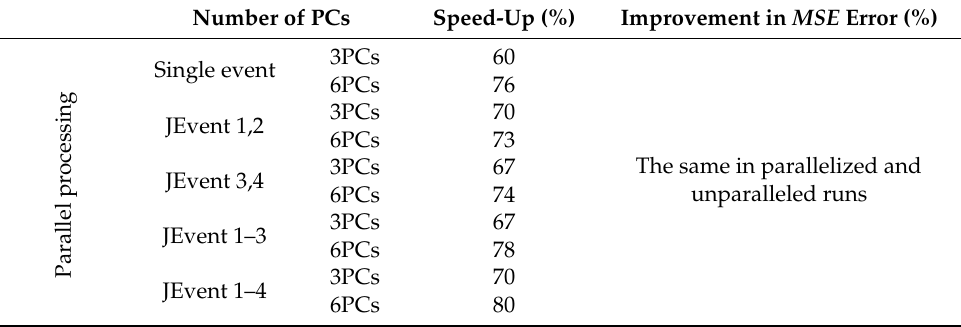
Table 5. Comparison of parallelization and surrogate models performance (negative MSE means percent of error compared to original HMS-PSO and positive one means a better estimation of MSE